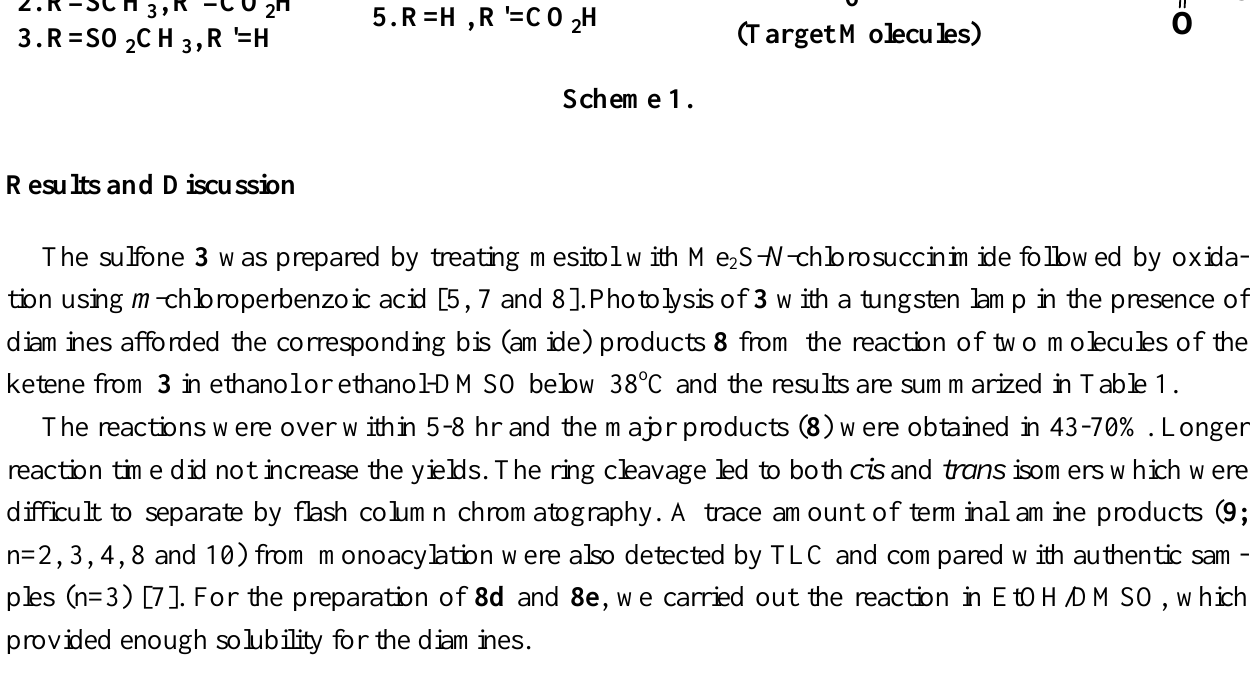
Table 1. Photolysis of cyclohexa-2,4-dienone ( 3 , 2.3 equiv.) in the presence of diamine